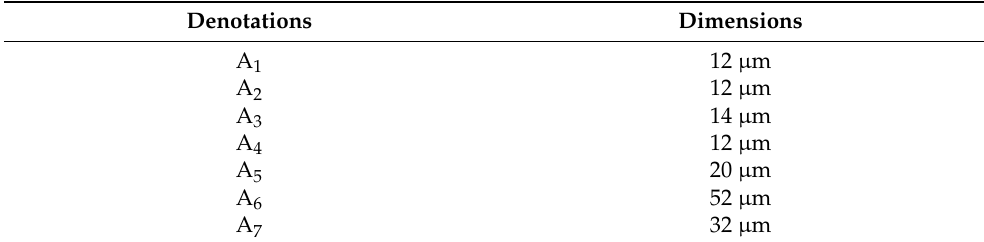
Table 1. Dimensions included in Figure 1.